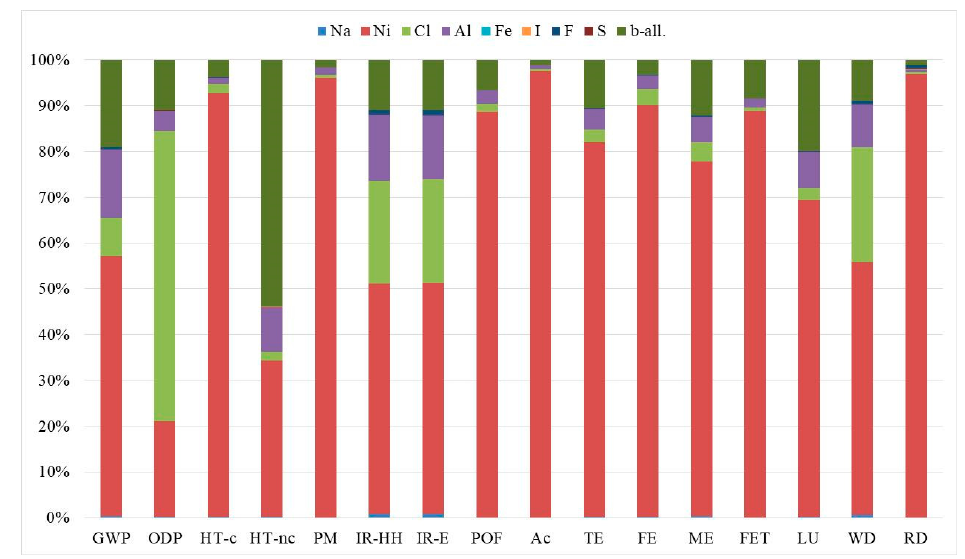
Figure 2. Environmental impacts of the planar cell: dominance analysis.